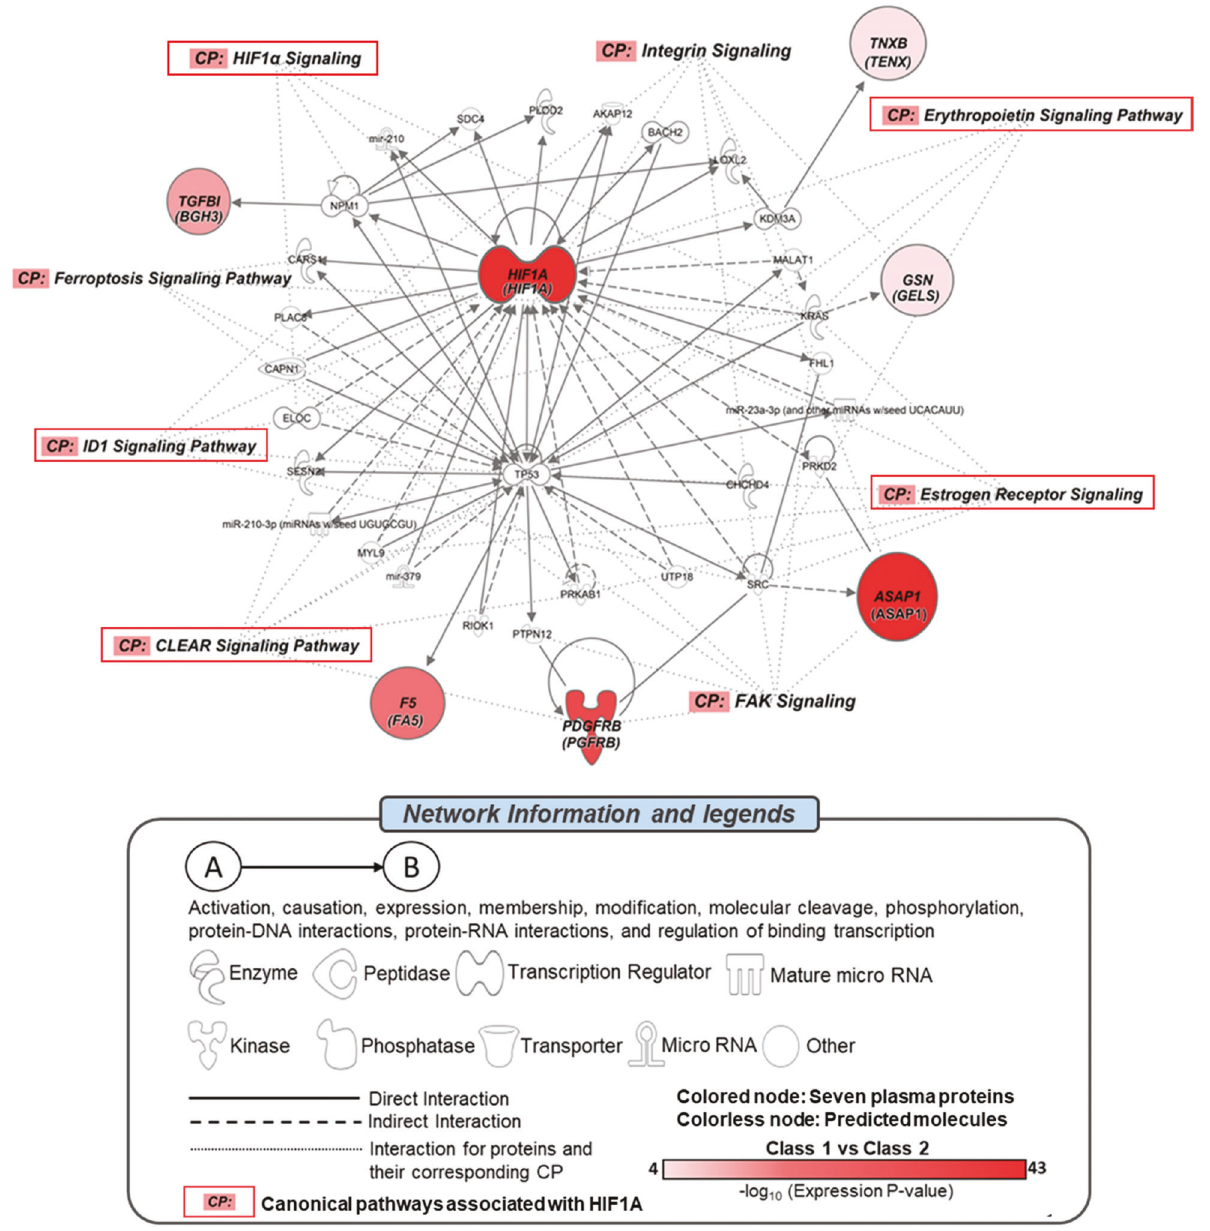
Fig. 1 Protein network and associated canonical pathways generated by IPA for eight proteins differentiating latent classes. Seven of the eight proteins were included in the protein network. Direct and indirect interactions are represented by solid and dashed lines. Proteins are represented by a gene symbol with a protein entry name in parentheses. Shapes notify the molecular classes of proteins de fi ned in the legend. Colored nodes notify the seven proteins, and white nodes represent predicted molecules. Canonical pathways involved in proteins in the network are represented by dotted lines. Canonical pathways in the red box are related to hub protein (HIF1A). Differences in protein expression levels of the seven features between the latent classes are represented by − log 10 (expression P value). IPA ingenuity pathway analysis, CP canonical associated with the gray matter volume of the bilateral frontal protein in the network analysis. HIF1A has been proposed to have opercula, and that no association exists between the diagnosis of a protective effect on depression [28]. However, its mRNA the patients and the gray matter volume [30]. However, the study expression within peripheral white blood cells seems to be clustered the patients based on clinical data and analyzed the state-dependent in MDD and BD [29]. Although further studies are associations with gray matter volumes, showing multiple associa- needed, this does imply that these diseases could be commonly tions between other clinical clusters and other brain region involved in pathways of energy metabolism and oxidative stress. volumes [30], which differed from our bottom-up approach using Recent studies have started to apply transdiagnostic biological data to cluster patients. Another study by Chang et al. approaches to cluster patients with psychosis-affective disorders, (2021) subtyped transdiagnostic patients based on frontal- considering biological correlates. Stein et al. (2021) revealed that posterior functional imbalance and found that the distribution the negative syndrome in a transdiagnostic sample like ours is